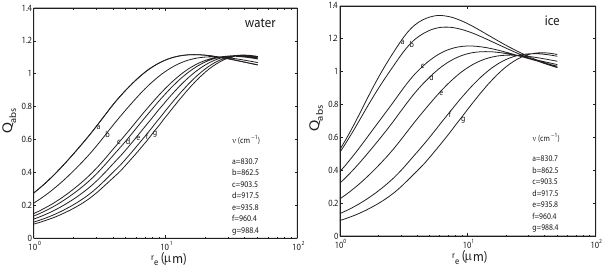
Fig. 3. Water and ice absorption efficiency Q abs as a function of cloud particle effective size r e at six different wavenumbers within atmospheric micro-windows where atmospheric gaseous absorption is particularly